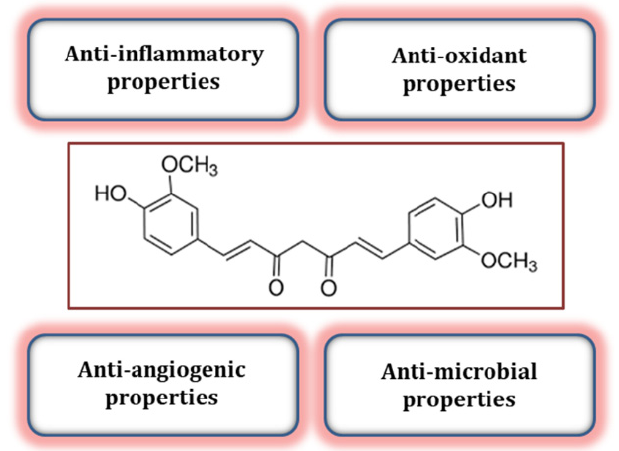
Figure 1. Chemical structure of curcumin (1,7-bis(4-hydroxy-3-methoxyphenyl)-1,6-heptadiene-3,5- dione). Curcumin which is found in the rhizome of Curcuma longa (turmeric) as a strong natural polyphenol, has a number of biological activities, including antioxidant (could inhibit ROS-generating enzymes) and anti-inflammatory (could block NF- κ B activation) properties, anti-cancer, anti-obesity, and anti-infertility effects [9].